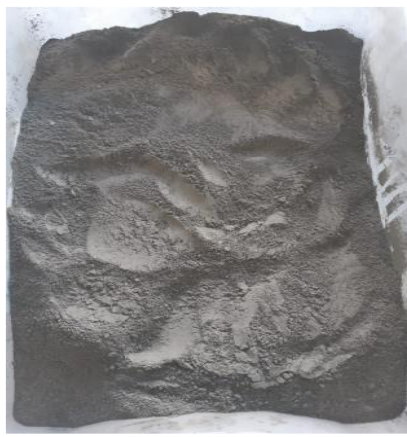
Figure 1. Mine tailing used in this study.